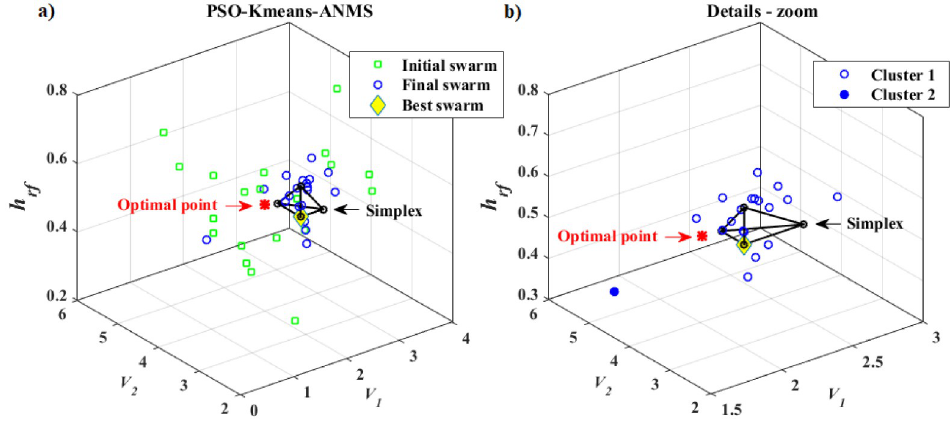
Fig 17. Case 1 (100 × 20). (a) The jumping moment from Phase 1 (PSO-Kmeans) for Phase 2 (ANMS). Represented by the color green (initial swarm), blue (final swarm), yellow (best solution for PSO) and red (optimal for ANMS) and (b) Details of Cluster 1 (empty blue circles), Cluster 2 (filled blue circles) and of the construction of the initial Simplex (black tetrahedron).